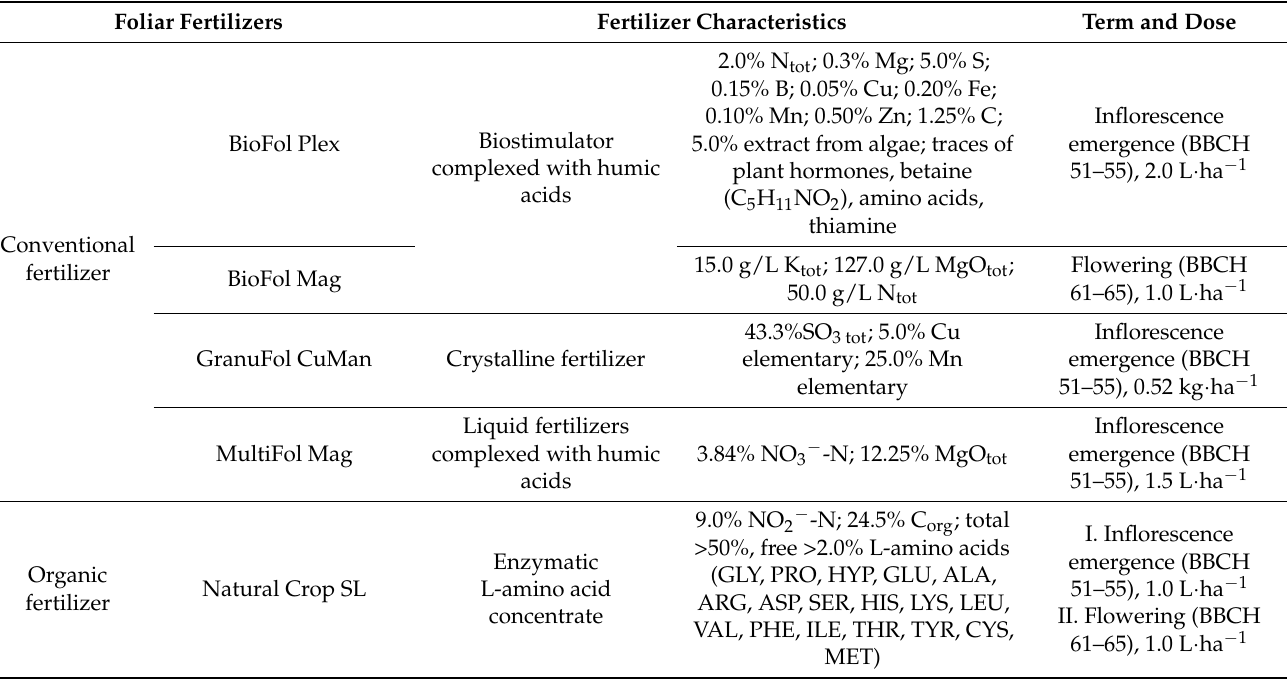
Table 1. The terms and doses of foliar fertilizers applied in the experiment. Foliar Fertilizers Fertilizer Characteristics Term and